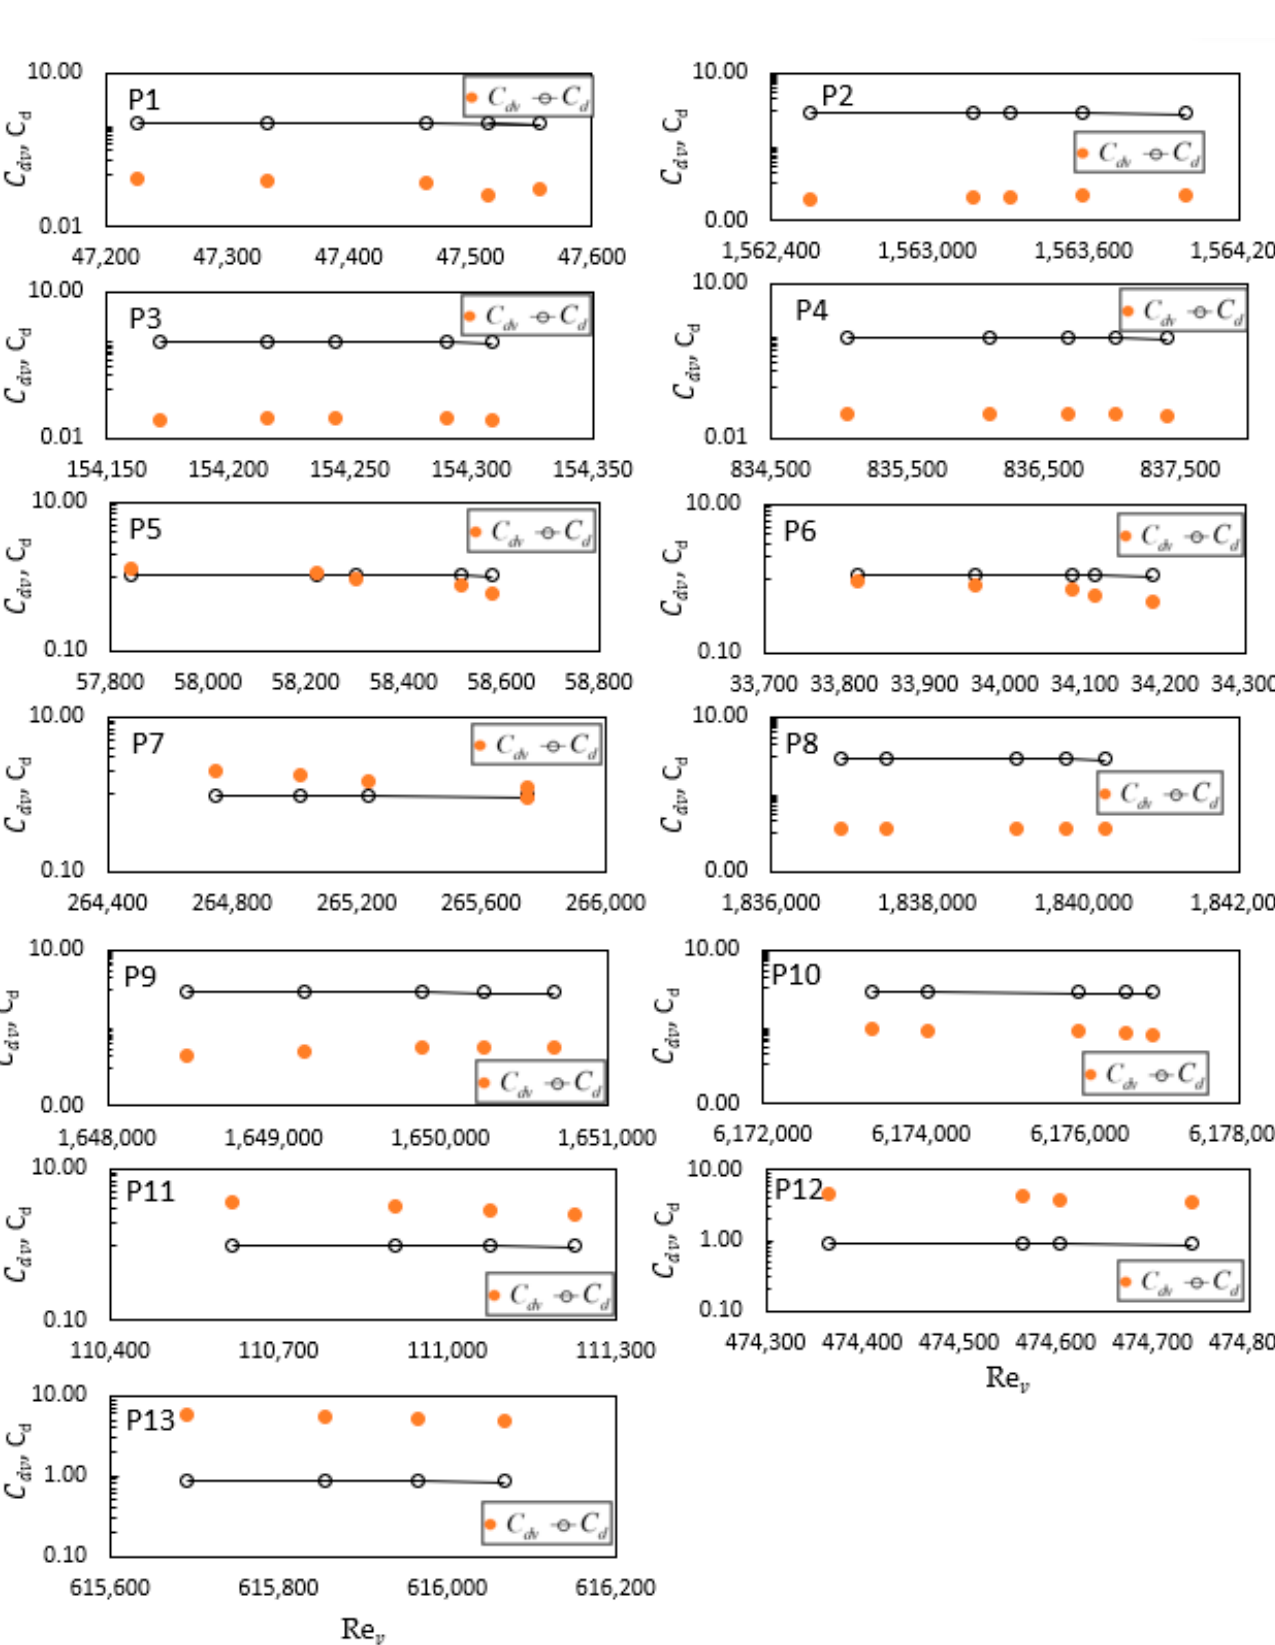
with 𝑅𝑒 (cid:3031)